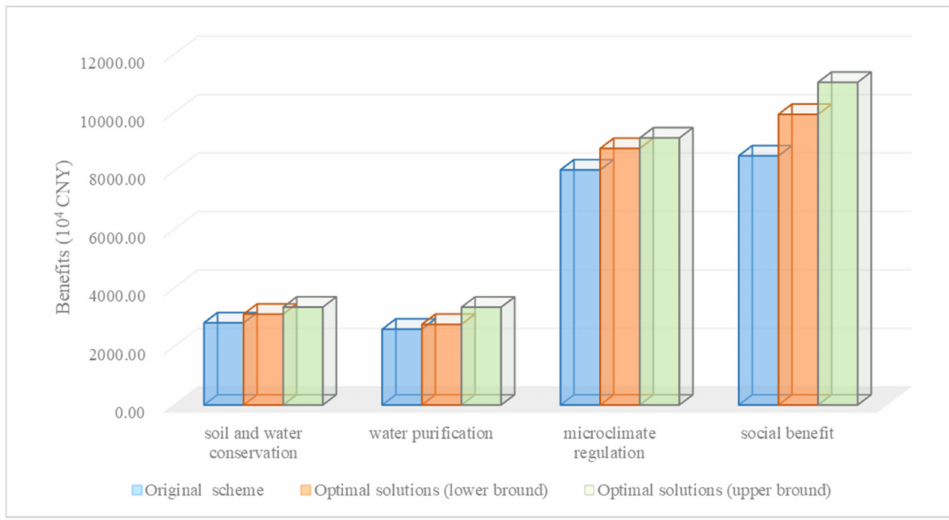
Figure 4. A comparison of benefits between the original project plan and the optimization